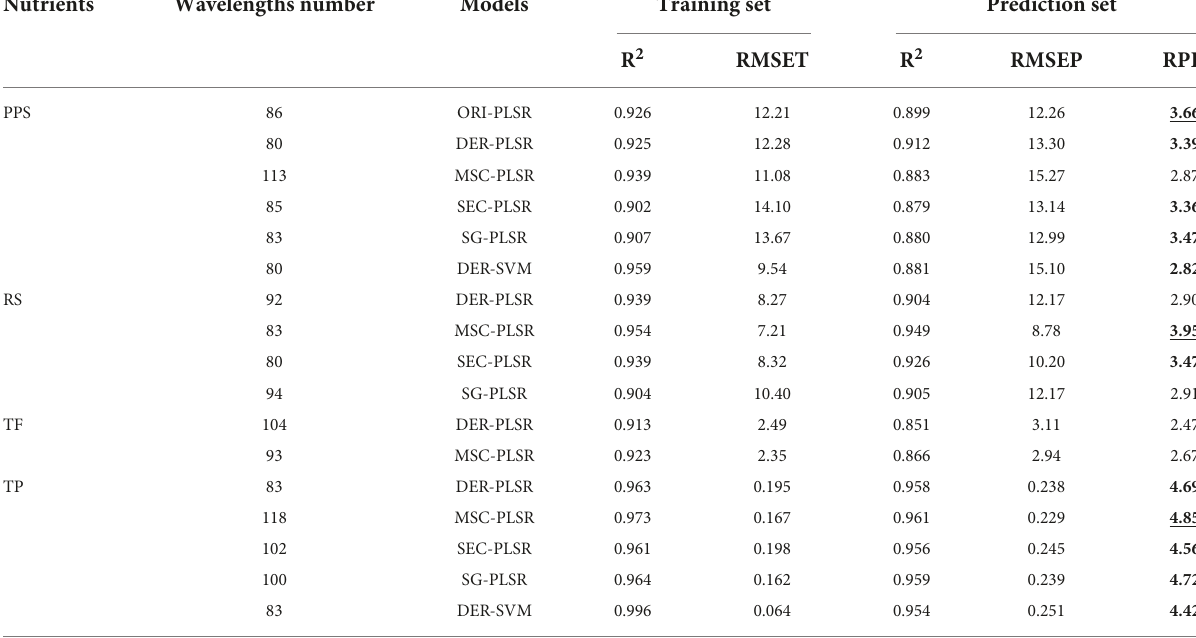
TABLE 1 Nutrient content prediction based on the effective wavelengths selected by the CARS method.